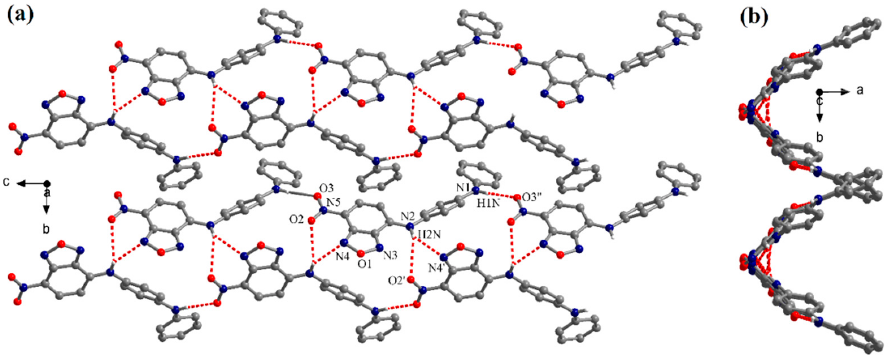
Figure 3. Views of the packing diagrams along the crystallographic a ( a ) and c axes ( b ).